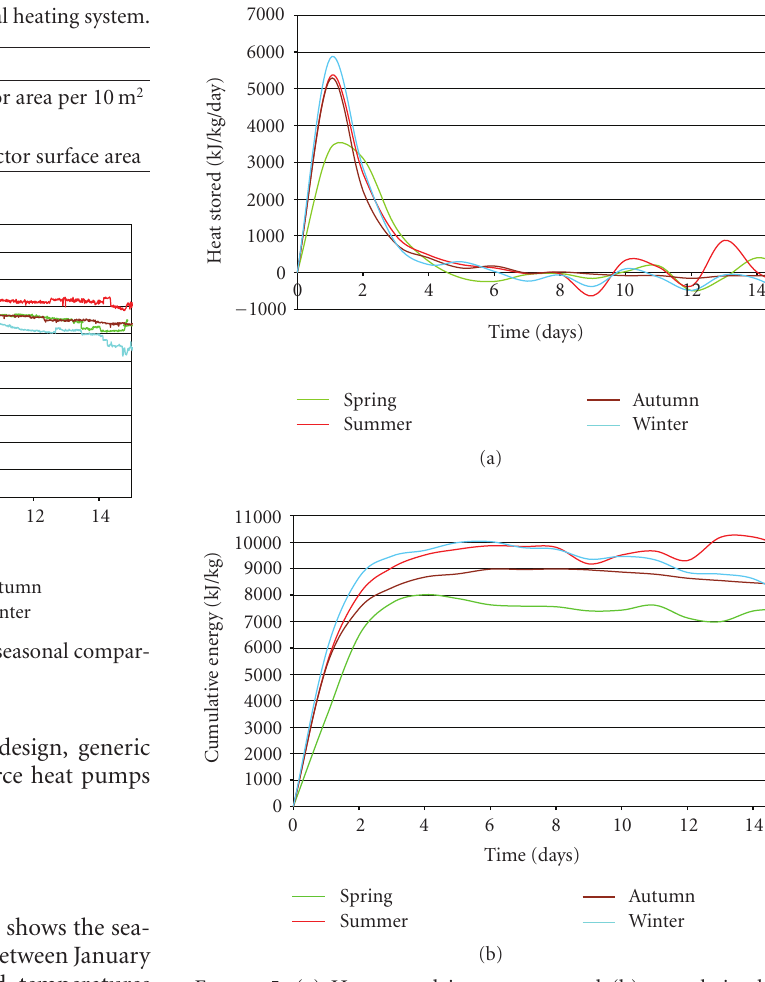
Figure 5: (a) Heat stored in compost, and (b) cumulative heat stored by compost; seasonal